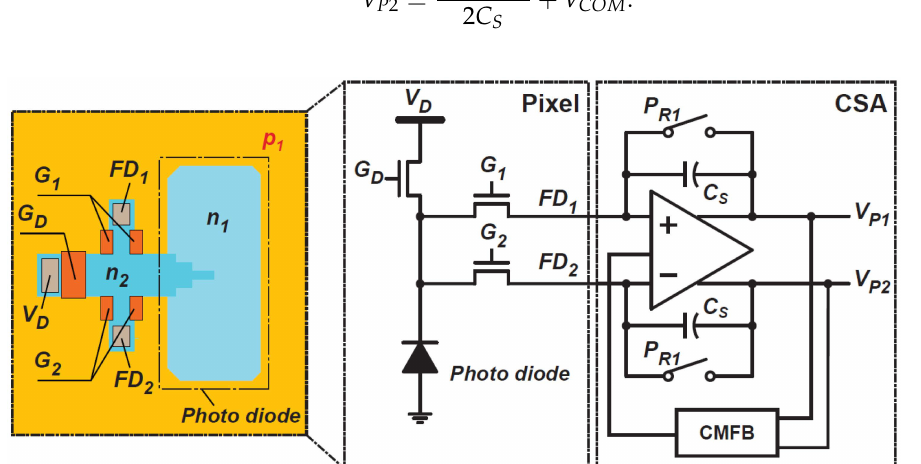
Figure 7. A circuit schematic of the photo-signal receiver and demodulator.